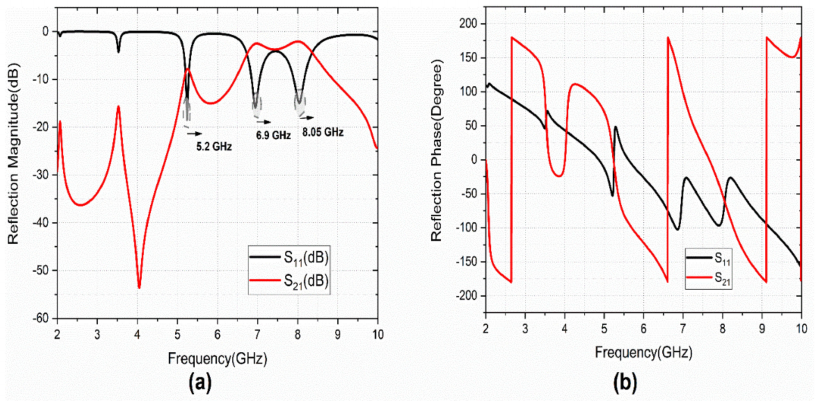
Figure 2. Simulated unit cell Co-and Cross-polarized Reflection characteristics ( a ) magnitude, ( b ) phase.